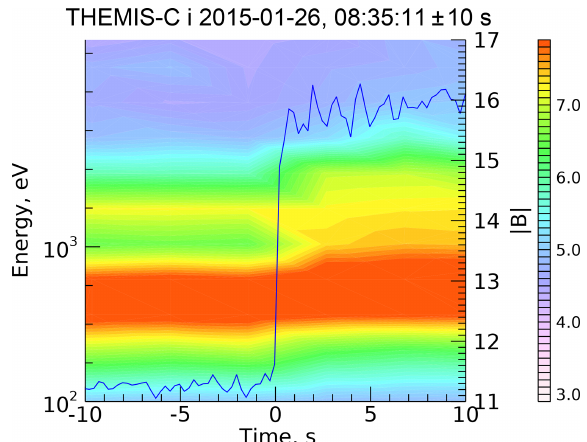
Figure 12. Magnetic profile of the 26 January 2015 THEMIS-C- measured